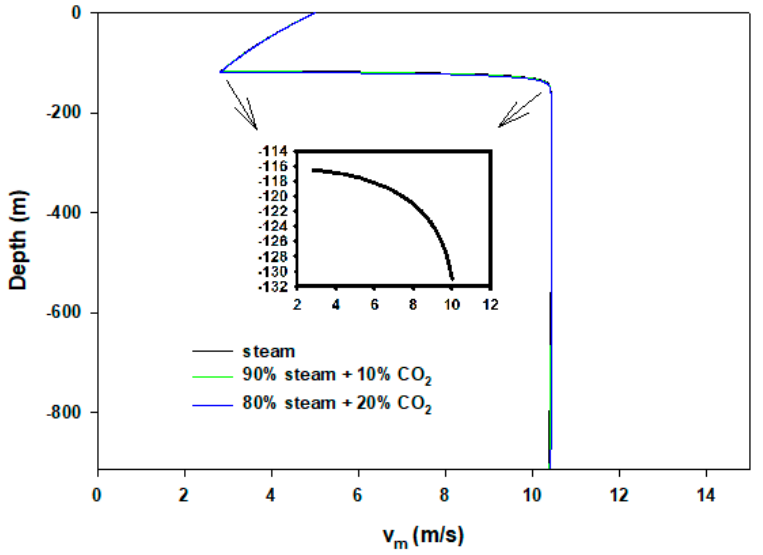
Figure 3. Velocity profiles of steam–CO 2 injections. Inset shows rapid rise of velocity right after condensation incepts.